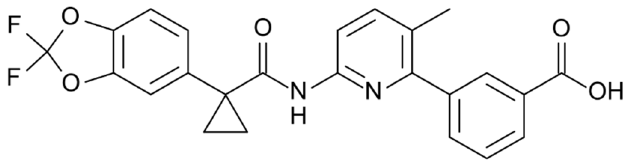
Figure 4. Chemical structure of Lumacaftor.